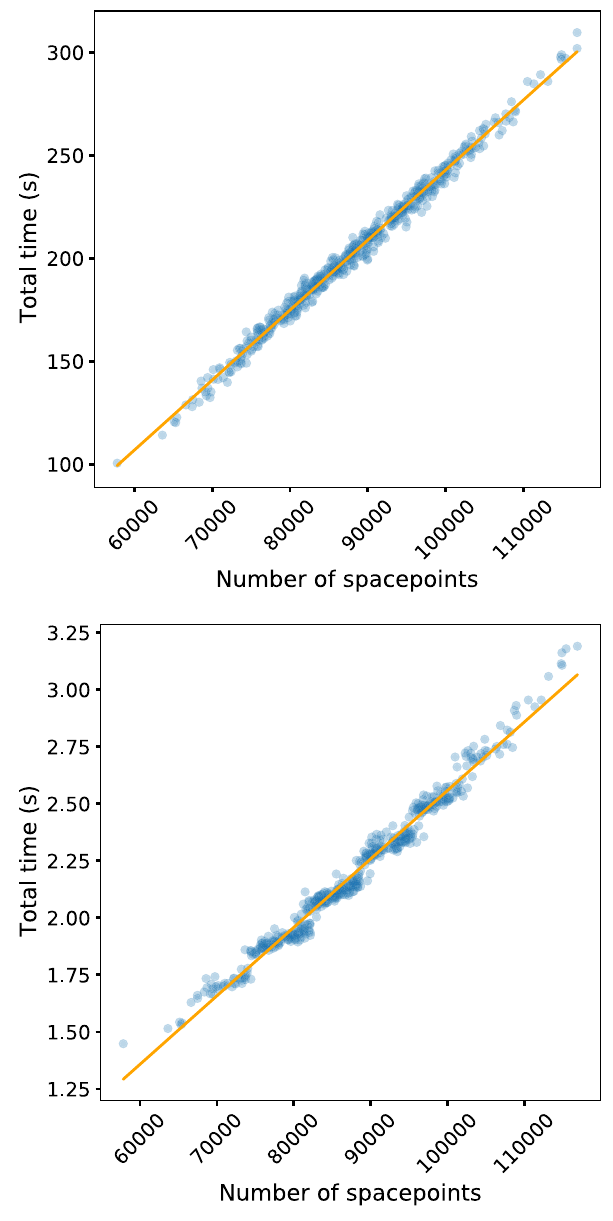
Fig. 9 Total inference time as a function of number of spacepoints in each event for CPUs (top) and GPUs (bottom)